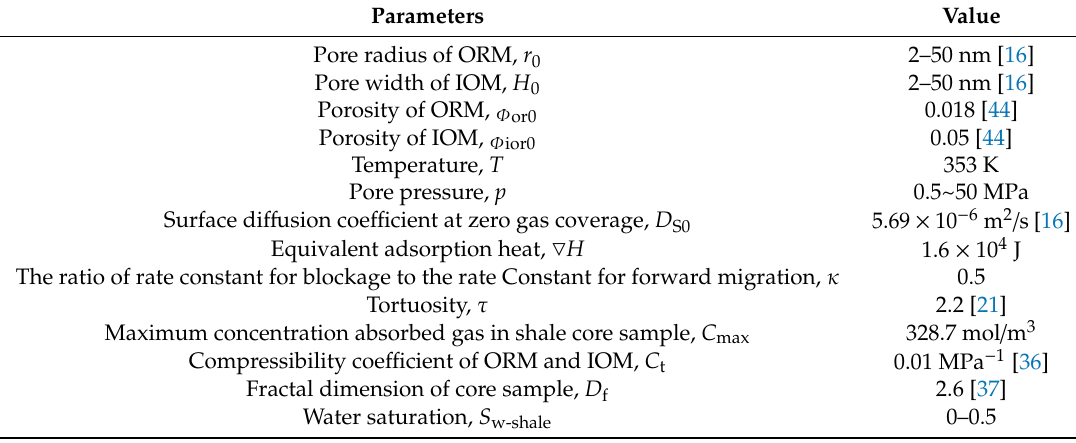
Table 2. Basic parameters of fluid and formation for sensitivity analysis.